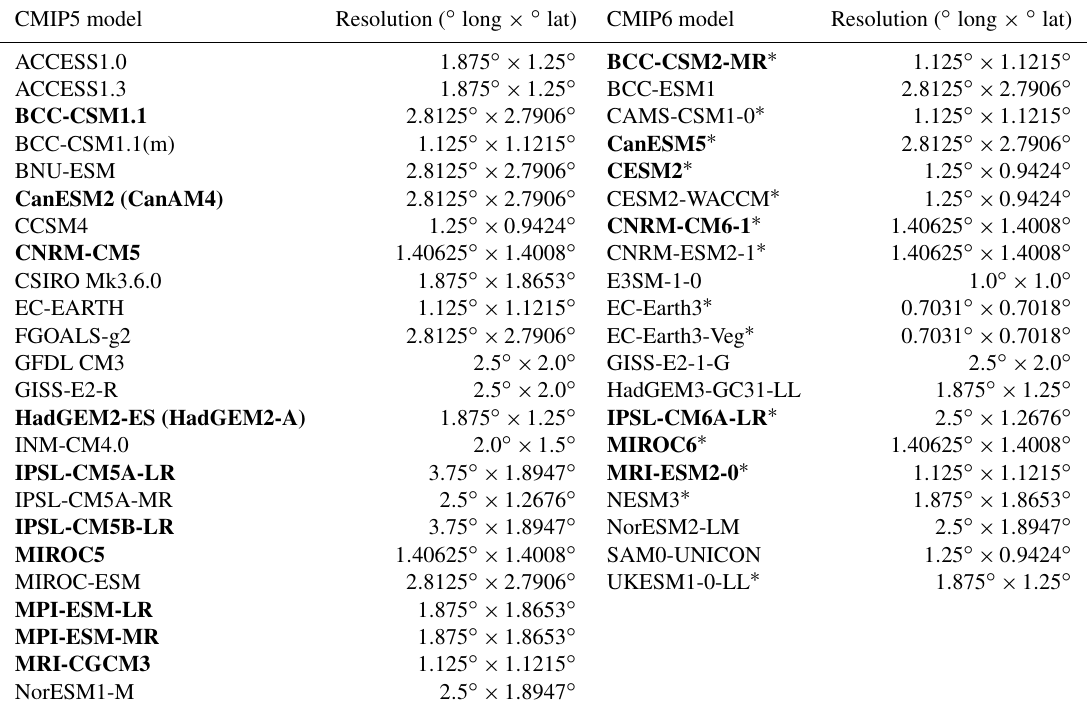
Table 1. Global climate models used in this study. Resolution indicates the horizontal resolution at which the data are provided. Bolded models denote those models with output available from the amip4 × CO 2 , amipFuture/amip-future4K, and amip4K/amip-p4K runs. The asterisks denote the CMIP6 models with output available from the SSP 5–8.5 run. The first ensemble member is used for each model, except in two cases when it is unavailable. In those cases, the “r8i1p1f1” ensemble member is used for the abrupt 4 × CO 2 run of EC-Earth3, and the “r2i1p1f1” ensemble member is used for the amip-p4K run of MIROC6.